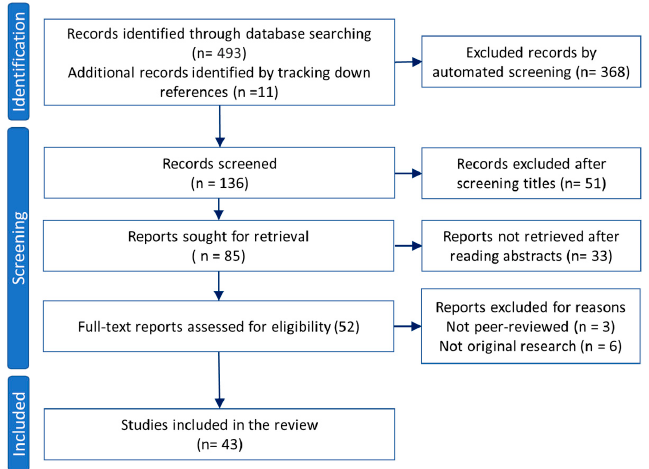
Figure 3. Study selection flowchart based on PRISMA 2020 guidelines. Table 1. QUS-based investigations performed on peripheral nerves.